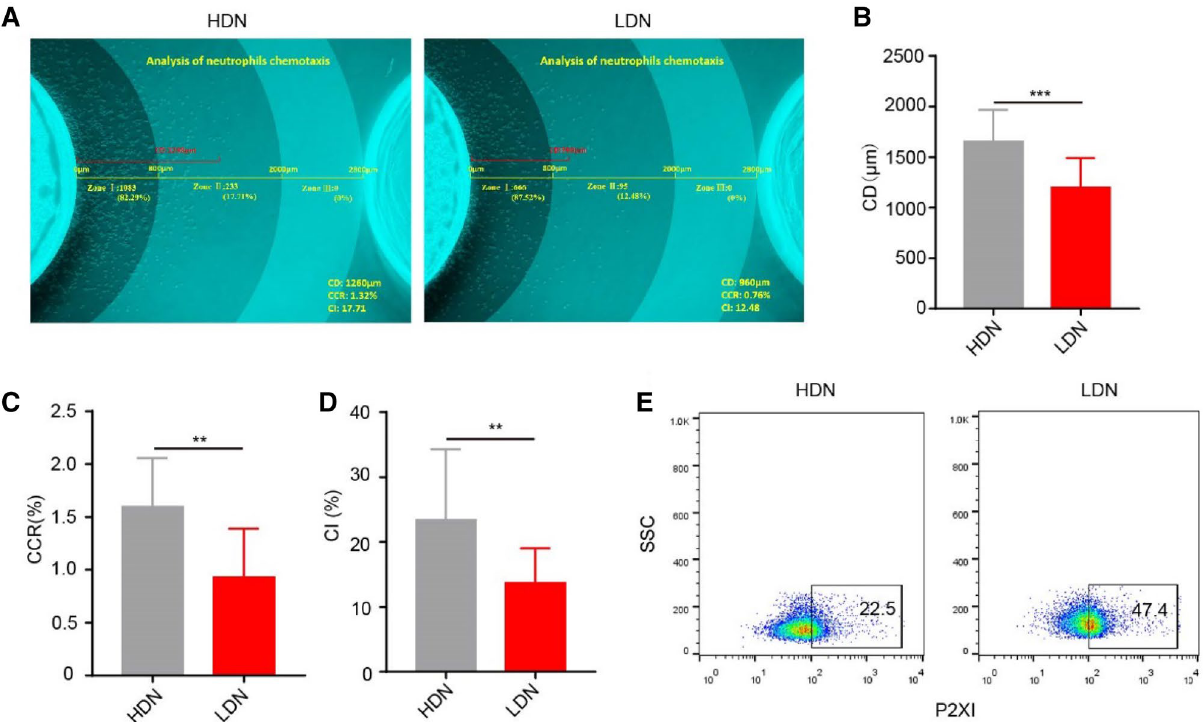
Figure 5. Reduced chemotactic function of LDNs. ( A ) Neutrophil chemotaxis toward fMLP was assayed. CD (chemotactic distance, μm), CCR (chemo cell ratio, cell number of zone I + II + III/Total cells in the side well, %), CI (chemo index, cell number of zone II + III/ Total number of chemotactic cells, %). ( B – D ) The evaluation indicators CD, CCR, and CI were significantly reduced in neutrophil chemotactic function evaluations of LDN. ( E ) The expression of P2X1 on HDNs and LDNs was analyzed using flow